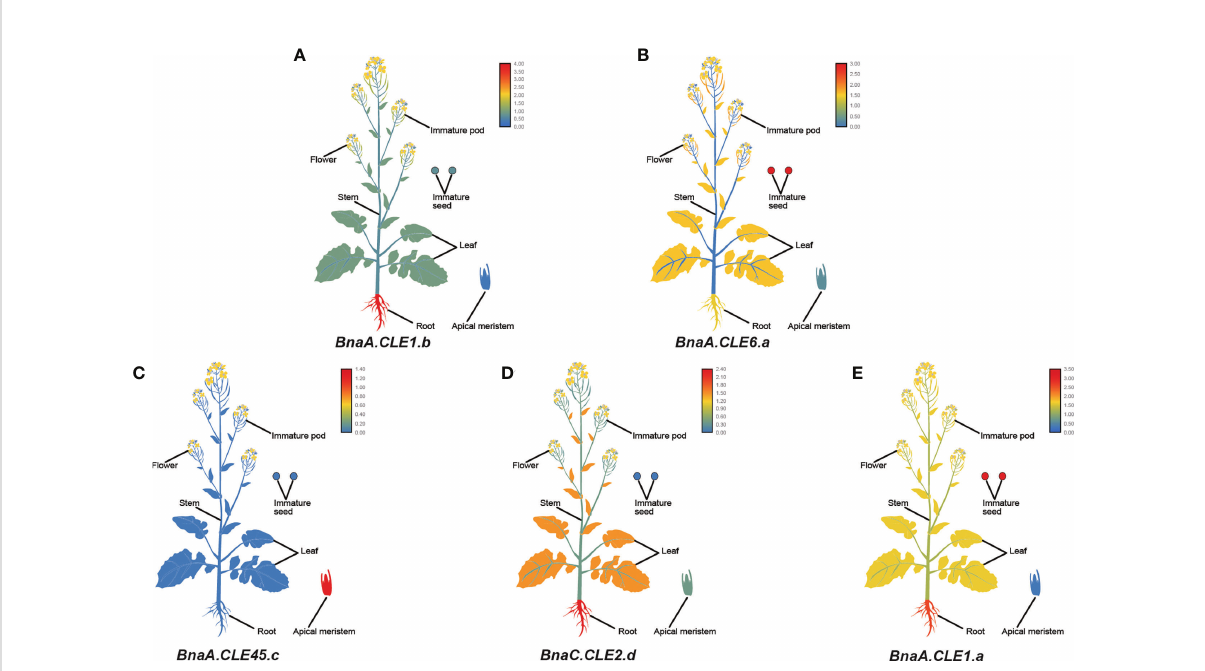
FIGURE 7 The expression patterns of fi ve selected CLE genes (A – E) in Brassica napus plants. Expression data were processed with log10 normalization. The color scale represents relative expression levels from low (blue color) to high (red